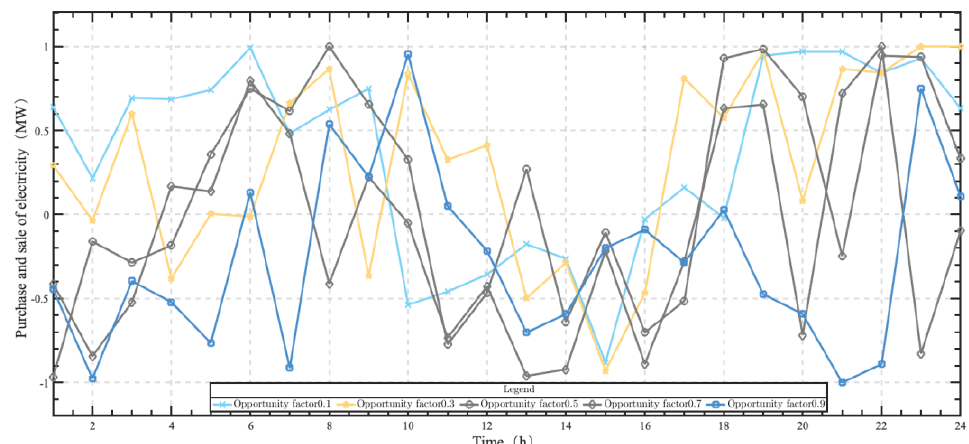
Figure 12. Opportunity decisions for DERA along with the opportunity factors.